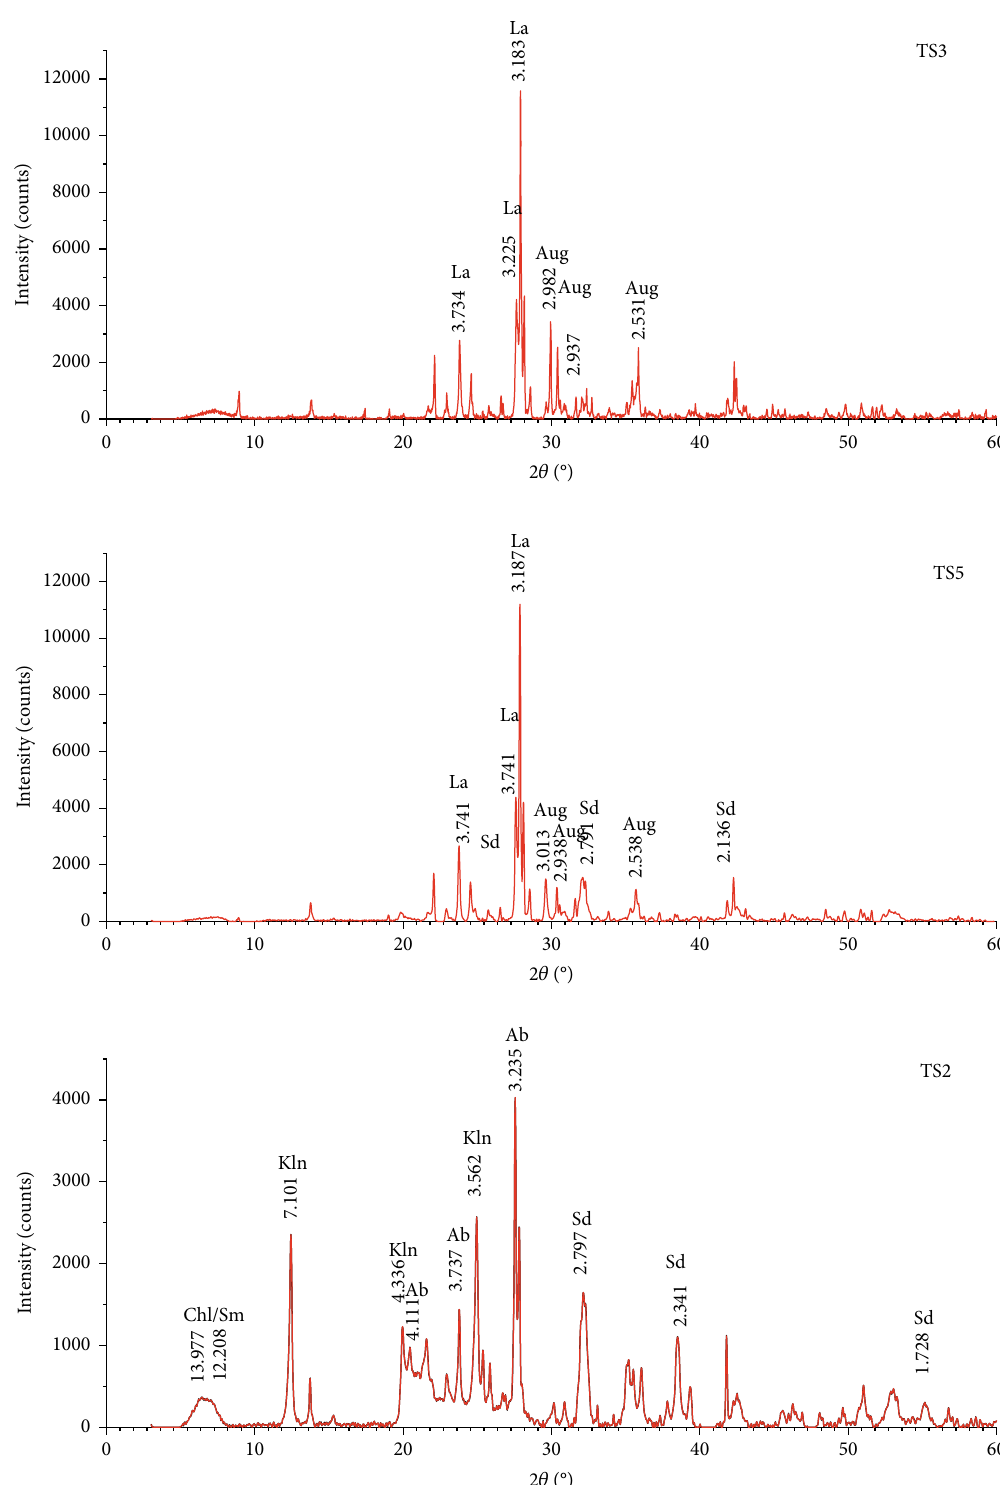
Figure 10: X-ray di ff ractograms of samples TS3, TS5, and TS2. La: labradorite; Aug: augite; Sd: siderite; Chl/Sm: mixtures of the chlorite and smectite groups; Kln: kaolin group; Ab: